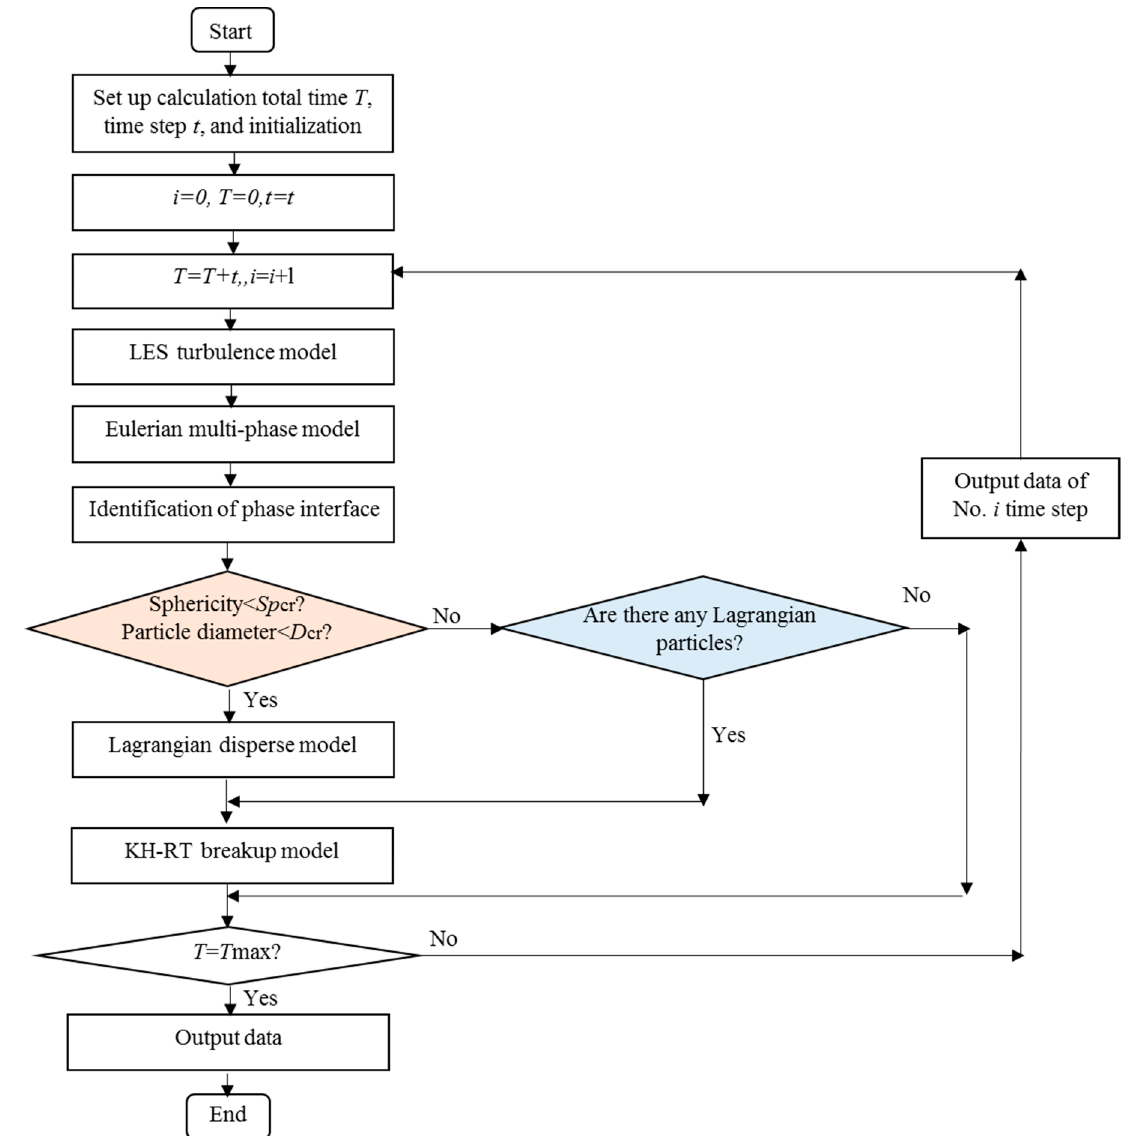
Figure 2. Simulation procedure of the improved ELSA model.